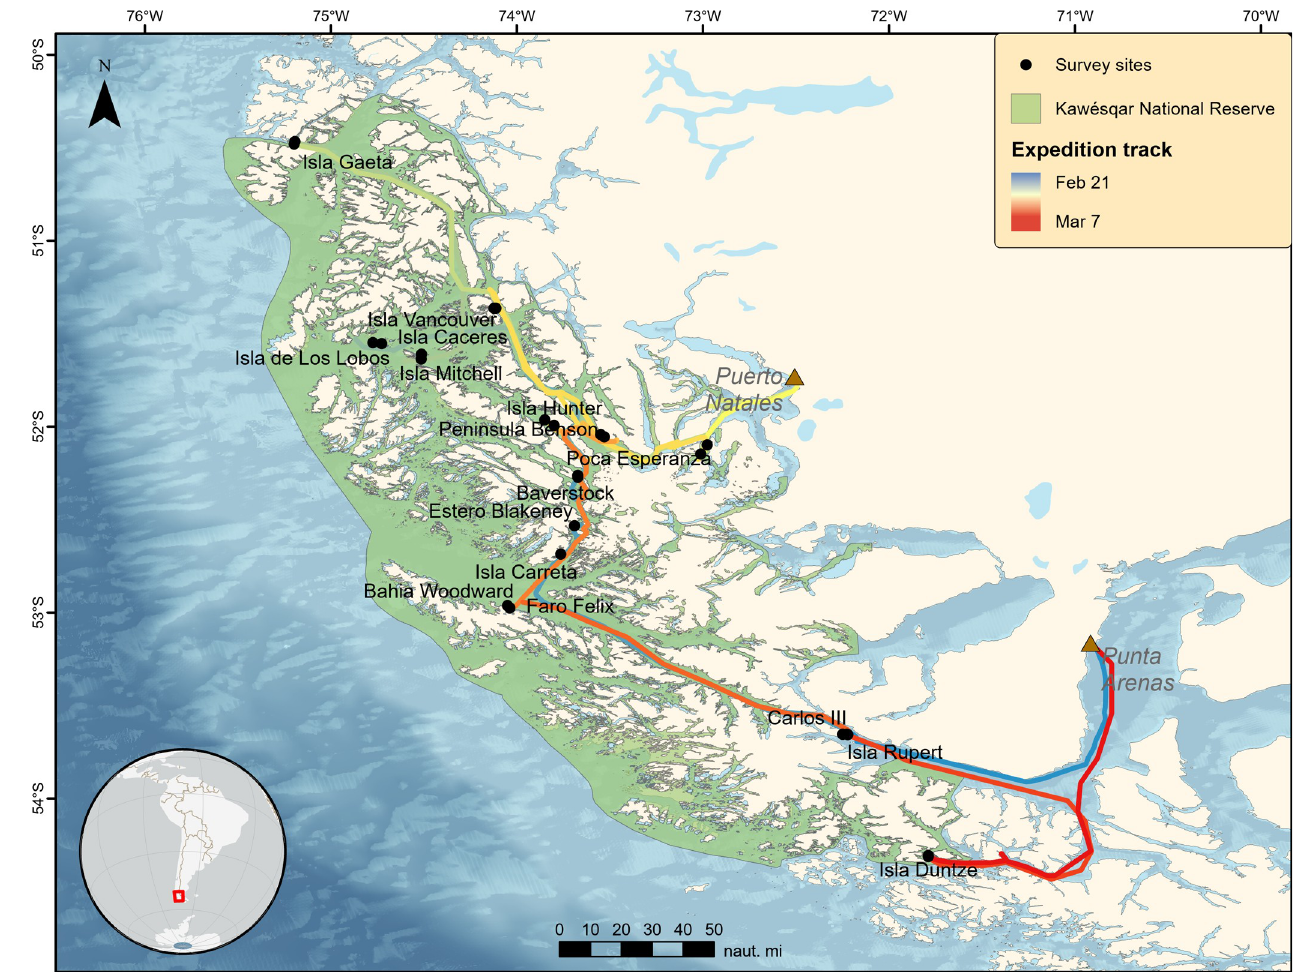
Fig 1. Locations visited on the expedition to the Kawe´sqar National Reserve. Basemap derived from GEBCO Compilation Group (2020) GEBCO 2020 Grid (doi:10.5285/a29c5465-b138-234de053-6c86abc040b9). Processing and assembly of the Global Self-consistent, Hierarchical, High-resolution Geography Database for shoreline data from